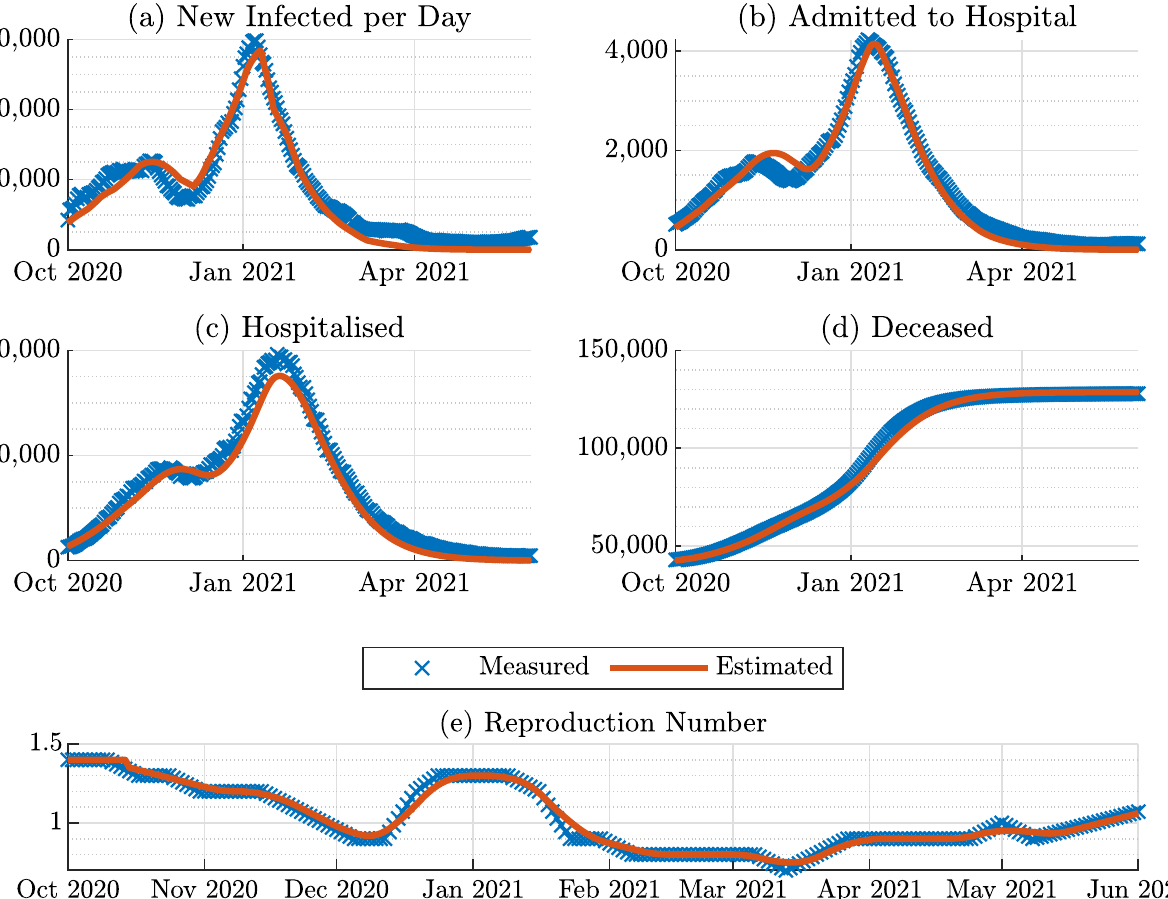
Figure 2. Comparison between measured data and estimation from the COVID-19 model identification: ( a ) Time histories of the people tested positive, ( b ) patients admitted to hospital, ( c ) patients in hospital, ( d ) deceased population, ( e ) and the reproduction number over R ( t ) the period October 2020-June